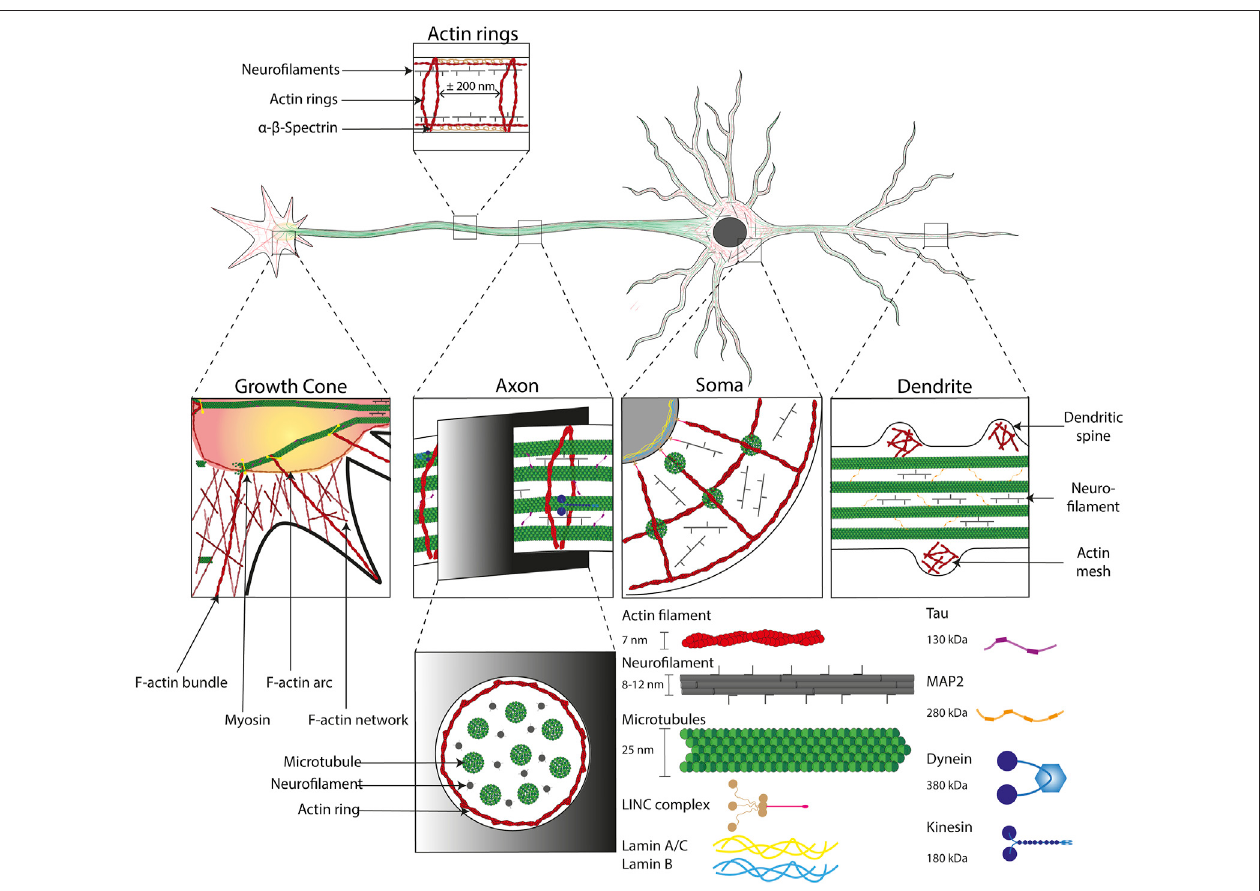
FIGURE 3 | Cytoskeletal organization in neuronal cells. Illustration of the cytoskeletal organization into the four major subcellular compartments of neuronal cells. From left to right: the growth cone, the axon, the cell body (Soma) and the dendrites. The cytoskeleton is composed of i) actin fi laments (~7 nm in diameter, in red) that form speci fi c structures, such as: bundles in growth cones, actin rings (interspace of ~200 nm) in axons, F-actin arcs in Soma and dendritic spines, ii) neuro fi laments (8 – 12 nmindiameter)whichhaveasupportingroleandiii)microtubules(~25 nmindiameter)stabilizedbytheTauprotein(130 kDa)inaxonsandtheMAP2protein (280 kDa) in dendrites. The microtubule network enables the formation of tracks in axons that support axonal transport through molecular motors allowing a retrograde transport (from the growth cone to the Soma) with dynein (380 kDa) and anterograde transport (from the Soma to the Soma) with kinesin (180 kDa). Cytoskeletal components are intimately linked to the nucleus with LINC complex, which is itself anchored to the lamin network (14 – 30 nm thick) inside the nucleus.